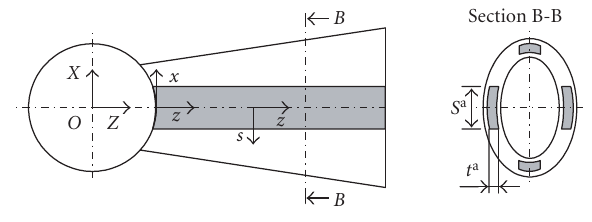
Figure 2: The distribution of piezoactuators.